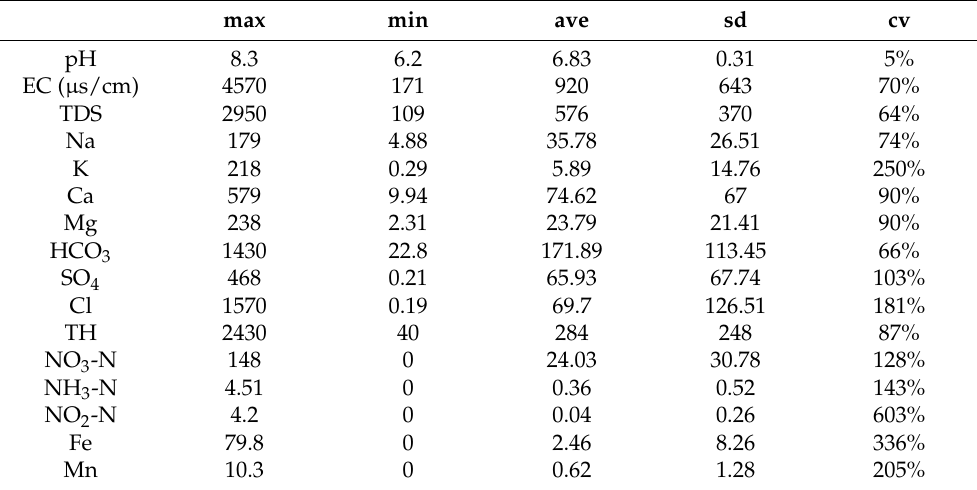
Table 2. Maximum, minimum and average chemical composition and variance of groundwater samples (all values are in mg/L, except for pH and